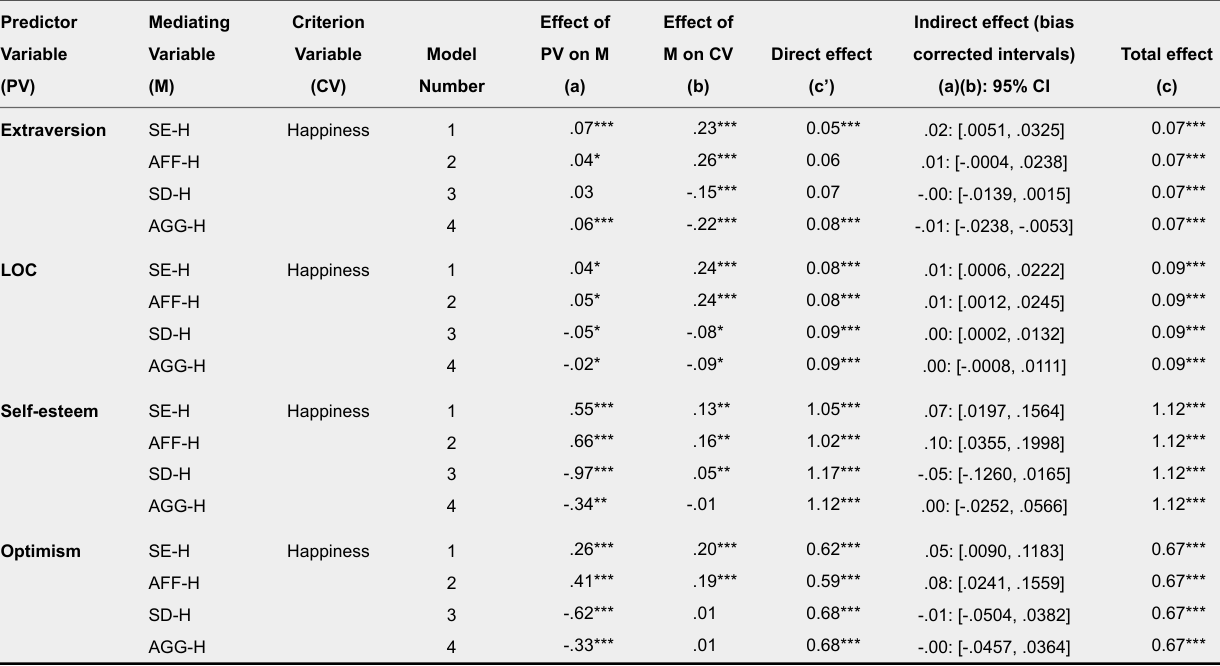
Summary of Mediation Analysis for Personality Traits and Happiness (N = 195; 10,000